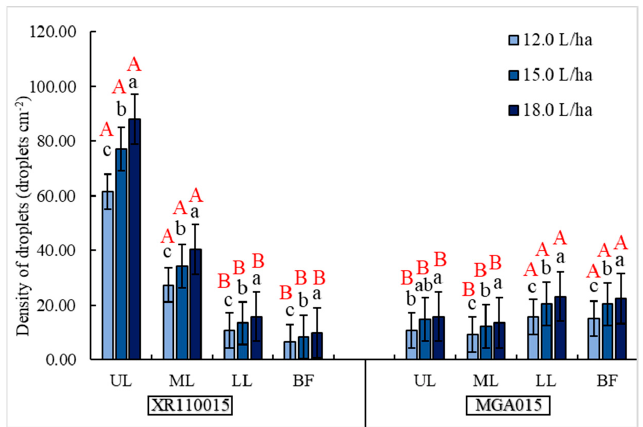
Figure 8. Droplet density (droplets cm -2 ) in the di ff erent collection positions: upper layer (UL), middle layer (ML), lower layer (LL), and bunch of fruit (BF) of papaya. Distinct le tt ers: lower case di ff er among the application rates and upper case di ff er among the spray nozzles in the respective collection layers, Tukey’s test at p ≤ 0.05.